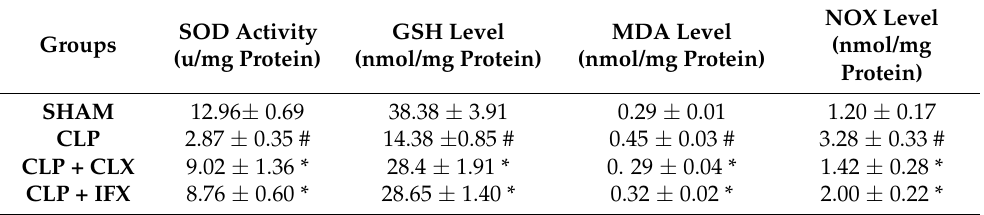
Table 1. CLX and IFX ameliorate sepsis-induced changes in pulmonary oxidative and antioxidant profiles in septic rats.